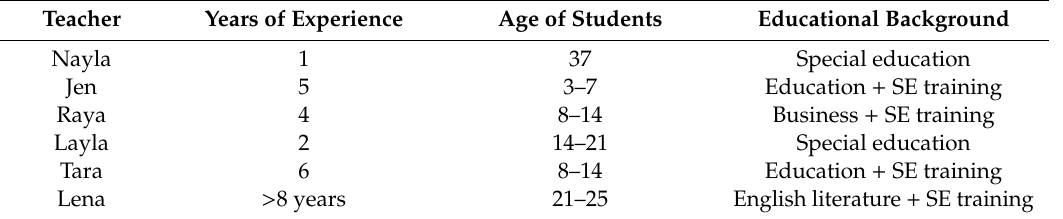
Table 1. Presentation of